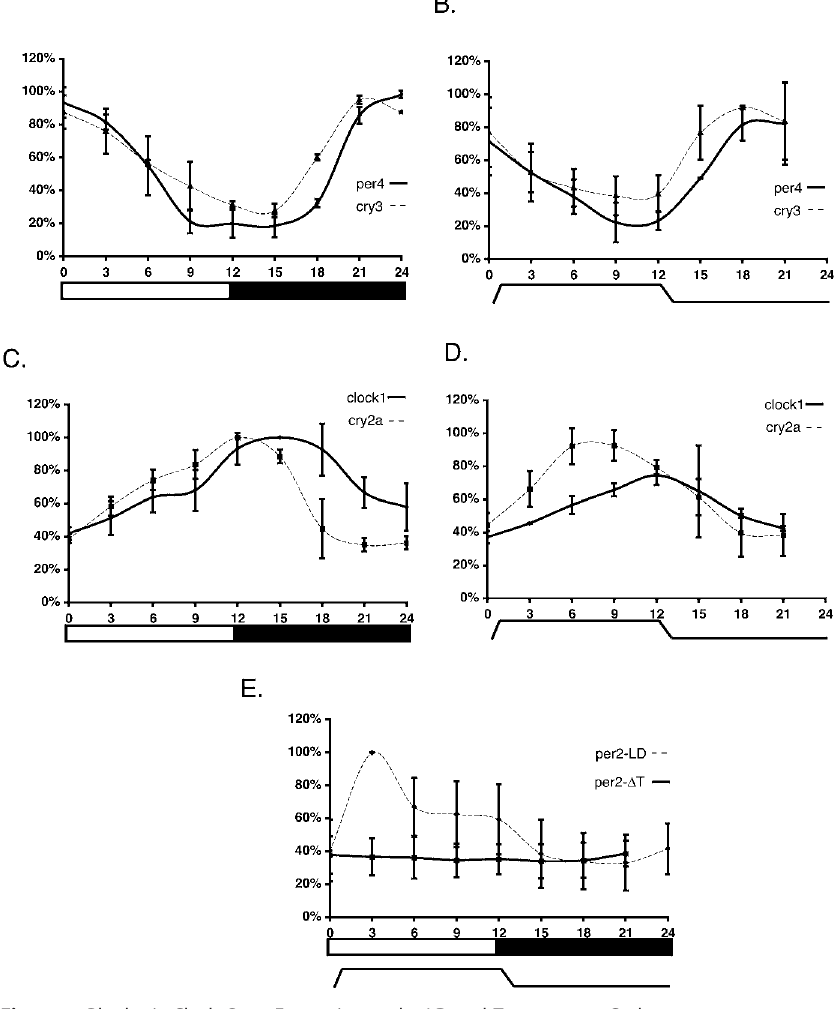
Figure 1. Rhythmic Clock Gene Expression under LD and Temperature Cycles Graphical summary of RPA assays are described: (A) Per4 (solid line) and cry3 mRNA expression (dashed line) in zebrafish larvae raised for 6 d either in a light (12 h) or dark (12 h) cycle at a constant temperature (25.3 8 C). (B) Per4 (solid line) and cry3 mRNA expression (dashed line) in zebrafish larvae raised for 6 d in DD, under a temperature cycle of 4 8 C (23.5 8 C/11 h, 27.5 8 C/11 h, plus 1 h for each heating and cooling phase). RNA samples were harvested during the seventh day (ZT0 is defined as the beginning of the heating and light periods). (C and D) Equivalent analysis of clock1 (solid line) and cry2a (dashed line) expression in (C) LD, and (D) temperature cycle larvae. (E) Per2 expression was assayed in LD (dashed line) or temperature cycle ( D T) larvae (solid line). By linear regression analysis, the slope of the D T trace has no significant deviation from zero (R 2 ¼ 0.033 and p ¼ 0.66, F-test). The LD cycle curve fits to a 6th-order polynomial regression model (R 2 ¼ 0.96 and Runs test for deviation from model p ¼ 0.99). In each case, zeitgeber time is plotted on the x -axis while the relative expression levels (percentage) are plotted on the y -axis. b -actin levels were used to standardize the results. The highest band intensity in each experiment was arbitrarily defined as 100%, and then all other values were expressed as a percentage of this value. All experiments were performed in triplicate, and error bars denote the standard deviation. DOI: 10.1371/journal.pbio.0030351.g001